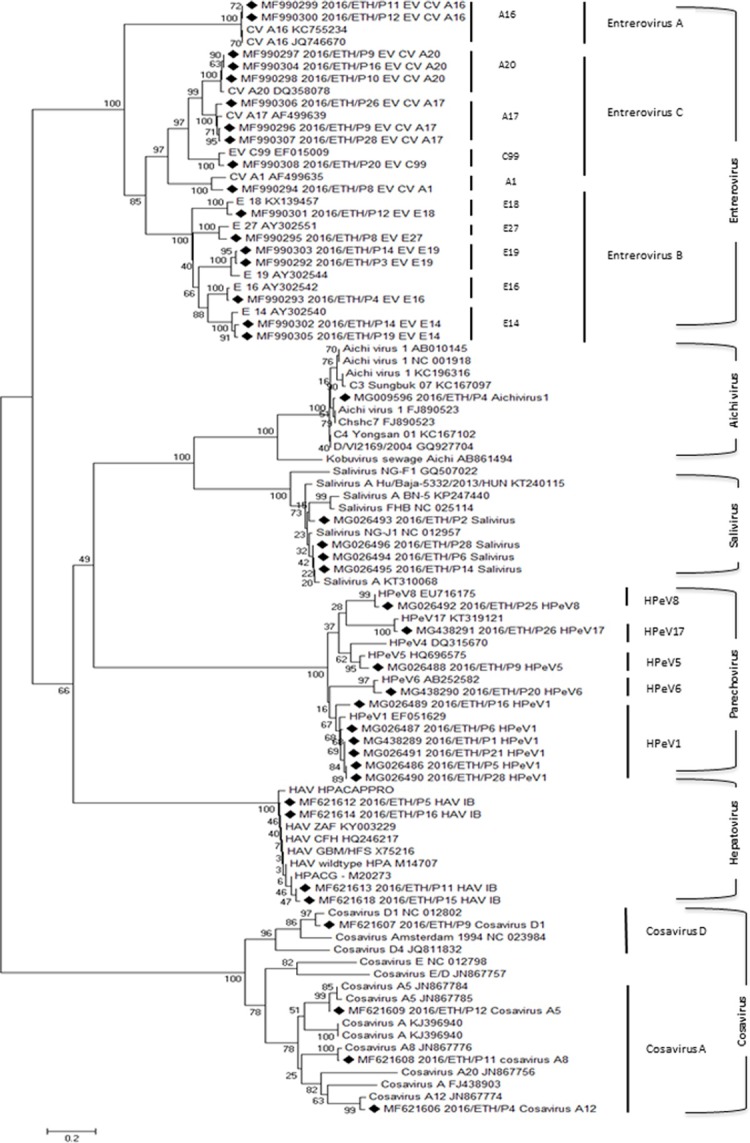
Phylogenetic analysis of VP1s from different genera of the Picornaviridae family.Viral sequences described here are highlighted by black diamonds.